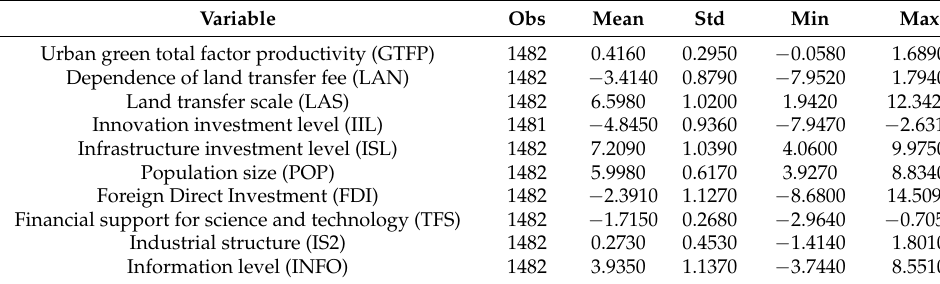
Table 3. Descriptive statistics of main variables (eastern region